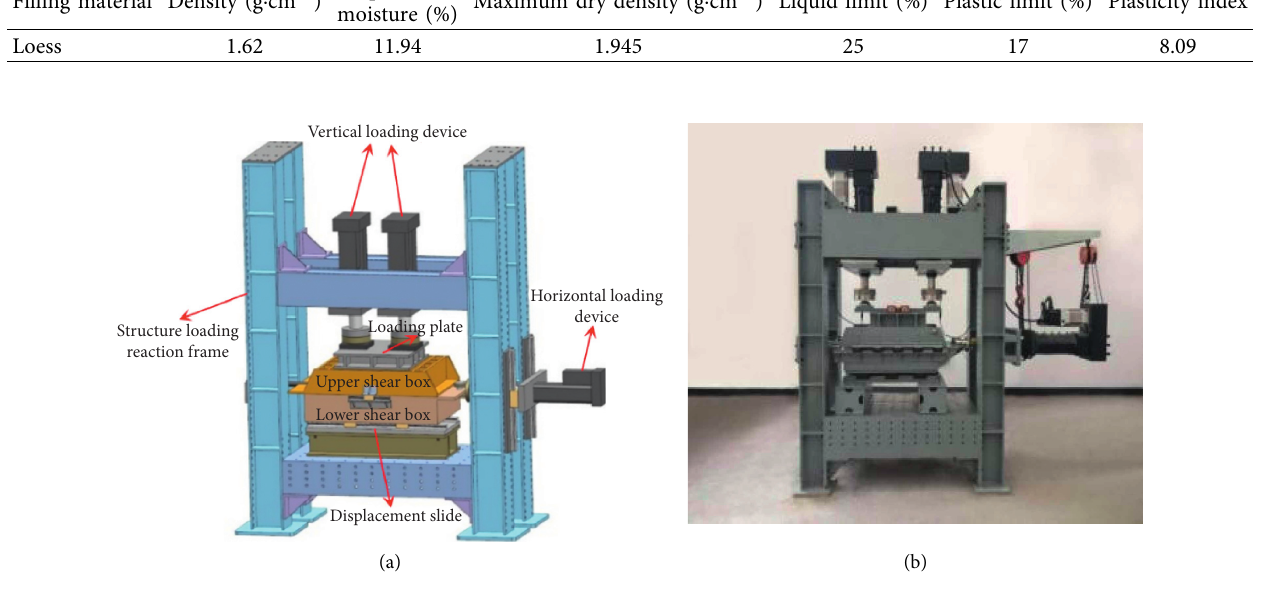
Figure 9: Large-scale direct shear apparatus. Table 6: Test schemes for different types of reinforcement.